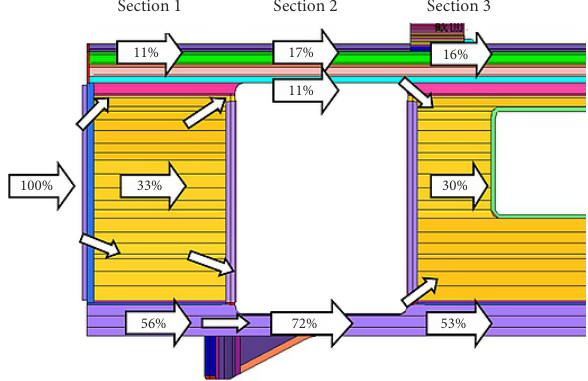
Figure 20. Transfer path distribution of the collision